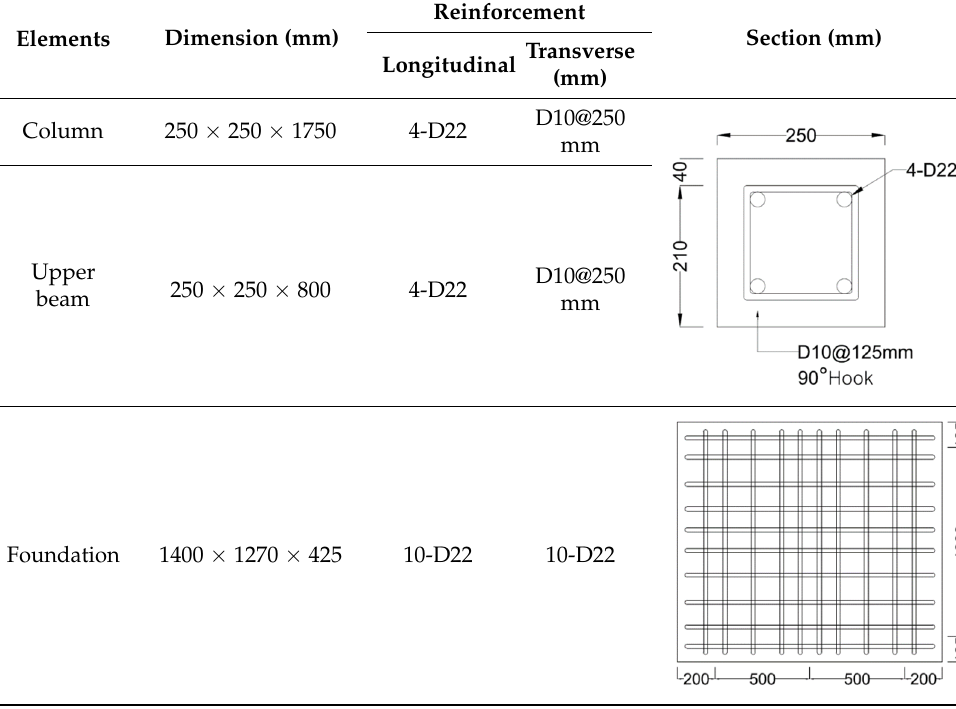
Table 2. Details of the specimens.